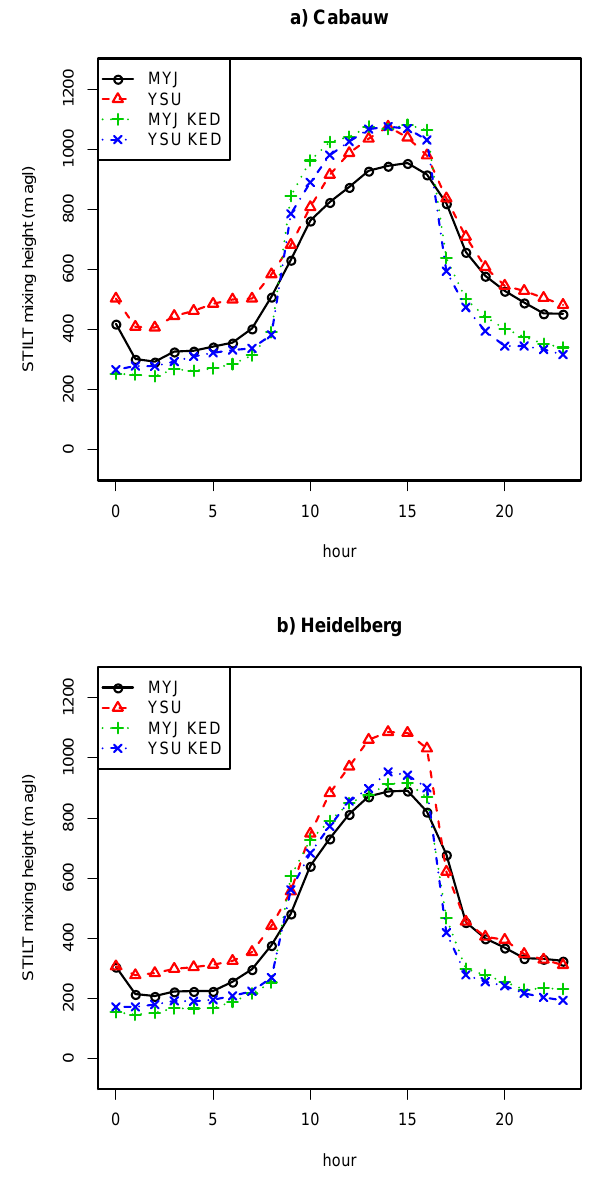
Figure 8. Comparison of averaged diurnal cycles of WRF derived (black dots, red triangles) and optimized MHs (green pluses, blue crosses) at Cabauw (a) and Heidelberg (b) . The KED optimization was done with the MYJ and YSU PBL scheme and using the MH observations. Average difference of MHs between the PBL schemes is minimized by the optimization as both converge to the condition- ing data. Note that there is no MH observation co-located with CBW or